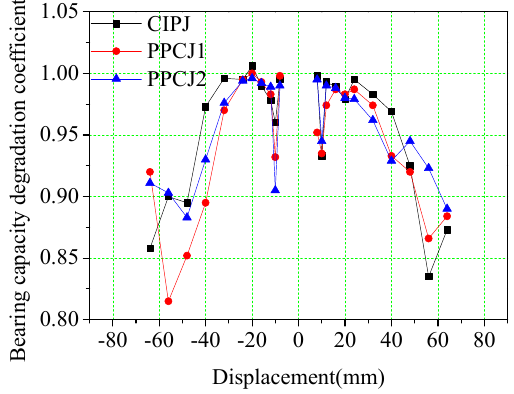
Figure 20. Bearing capacity degradation coefficient for left beam of joint.